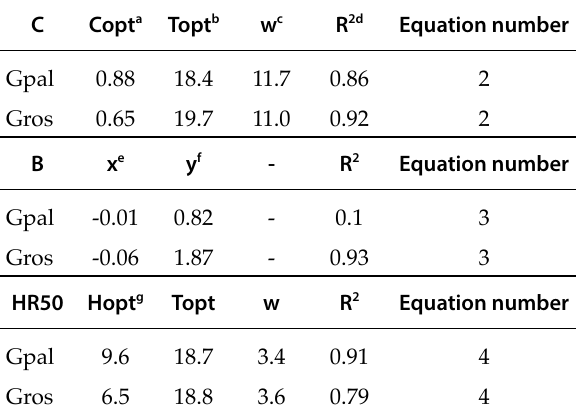
Table 1. Parameters for equations 2, 3 and4 describing the relationships of the logistic parameters C, B and HR50 with temperature for Globodera pallida (Gpal) and G. ros- tochiensis (Gros).